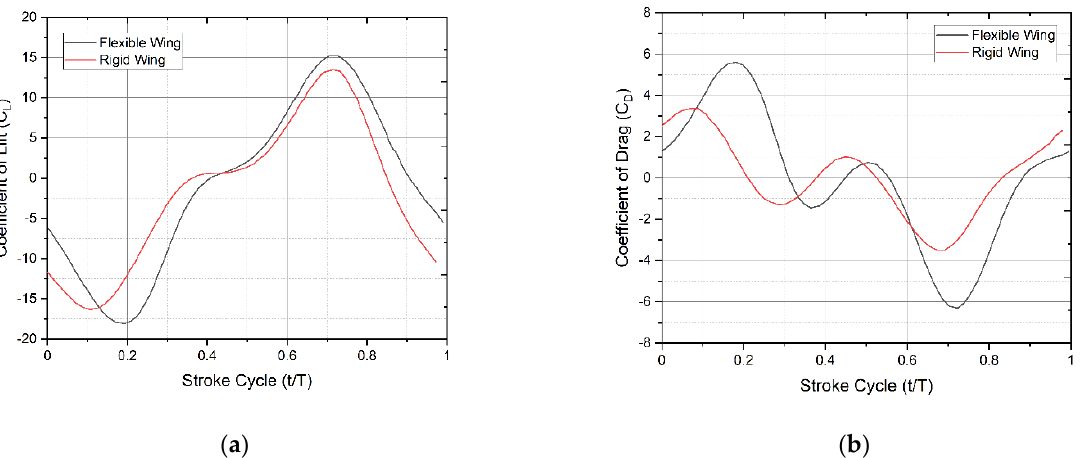
Figure 12. ( a ) Effect on lift production with respect to stroke cycle for corrugated rigid and flexible wing; ( b ) effect on drag with respect to stroke cycle for the corrugated rigid and flexible wing.